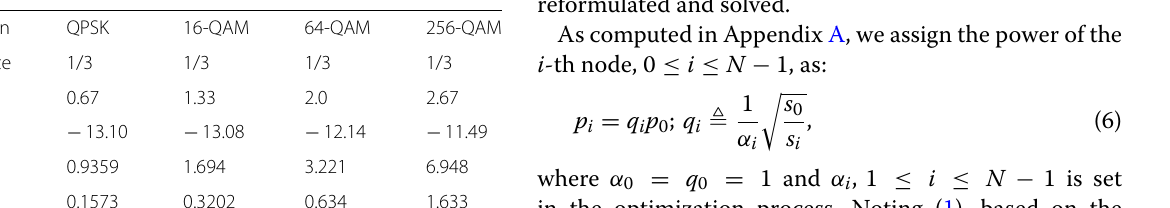
Table 1 Mode-dependent constants to estimate BLER in LTE standard using (2)